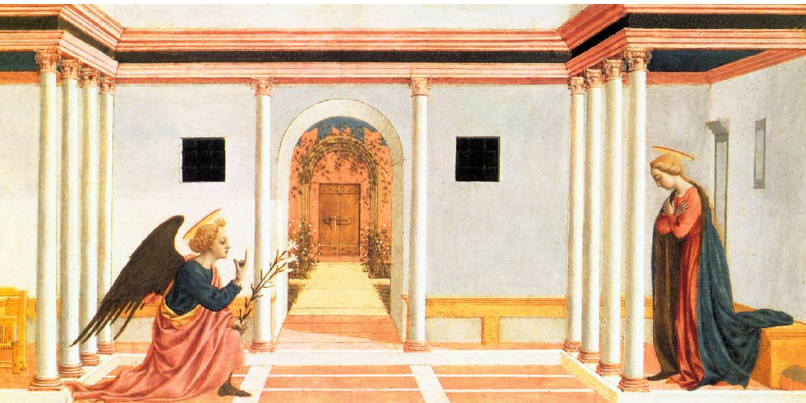
Figure 5. Domenico Veneziano, The Annunciation (predella of the Pala di Santa Lucia de’ Magnoli) , c. 1445. The Fitzwilliam Museum, Cambridge, UK.